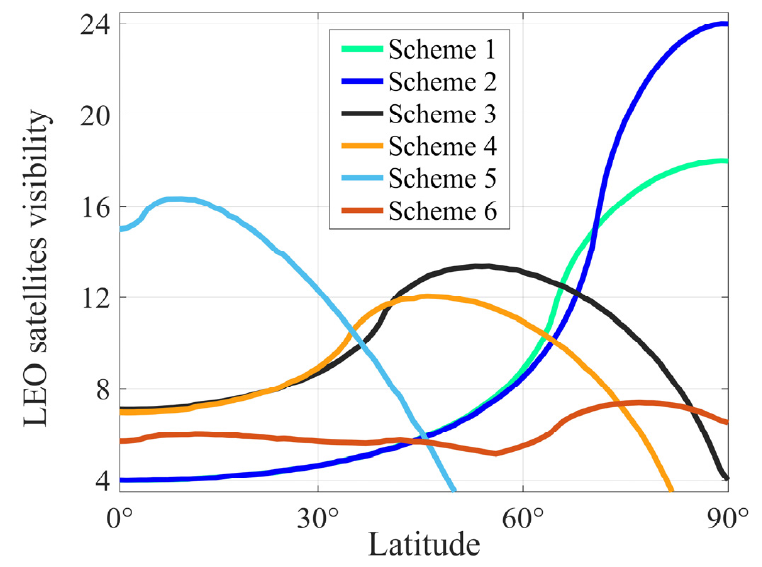
Figure 9. Coverage performance of six LEO constellations schemes. LEO constellations with different orbit parameters have great differences in satellite visibility. To satisfy the equally distributed LEO satellites as much as possible on a global scale, we designed mixed-orbit LEO constellations (LEO-mix), which are presented as Scheme 6. Each orbit of the LEO-mixed constellation contains 40 satellites. The